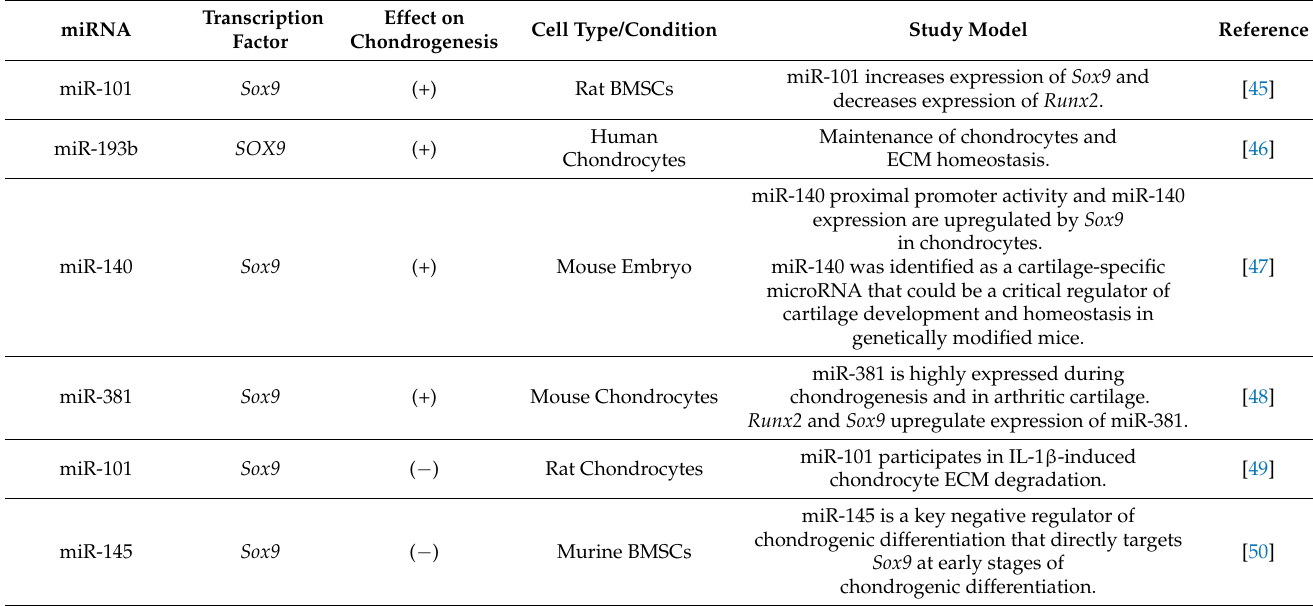
Table 1. MicroRNAs involved in transcription factor regulation during